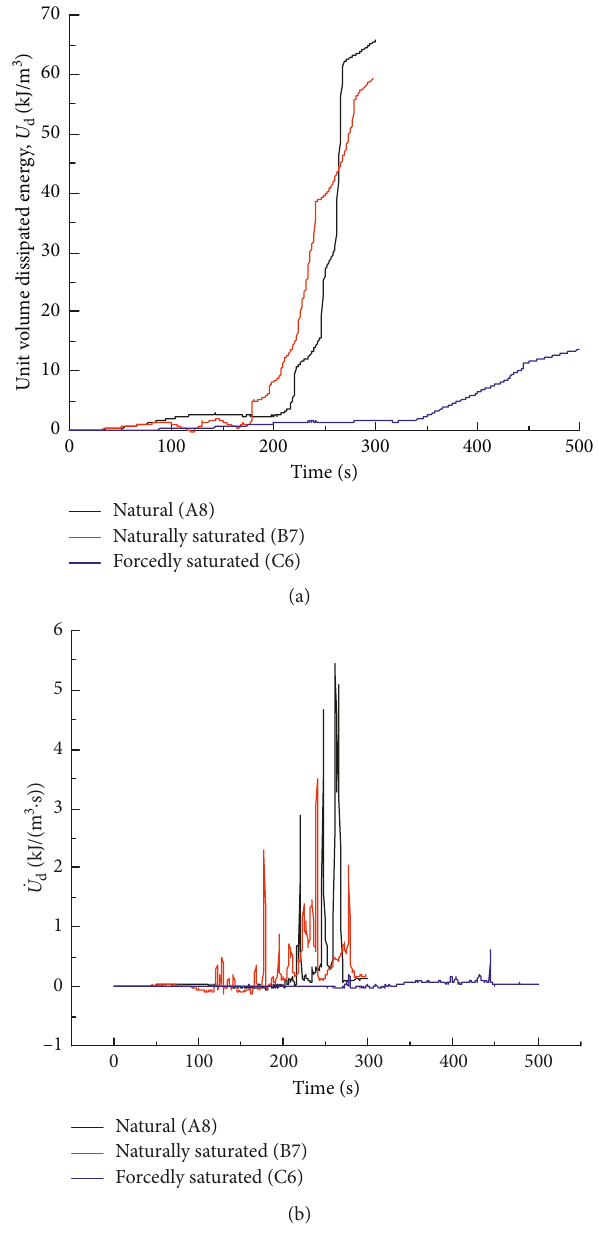
Figure 11: The unit volume dissipated energy variation of natural, naturally saturated and forcedly saturated coal samples under UCS tests: (a) U − t ; (b) _ U − t d d